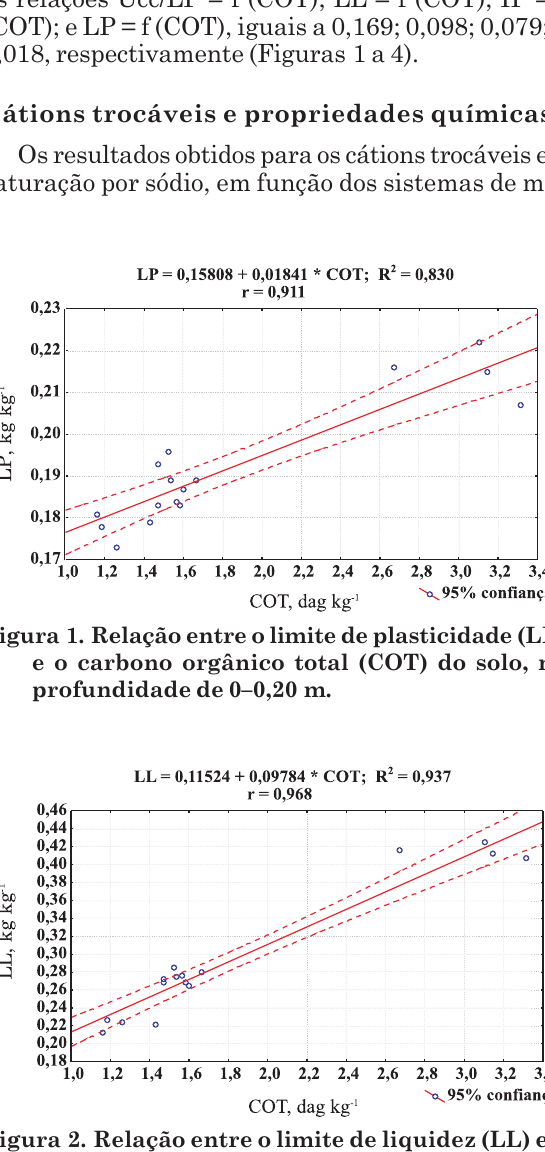
m.Figura 3. Relação entre o índice de plasticidade (IP) e o carbono orgânico total (COT) do solo, na profundidade de 0–0,20 m.